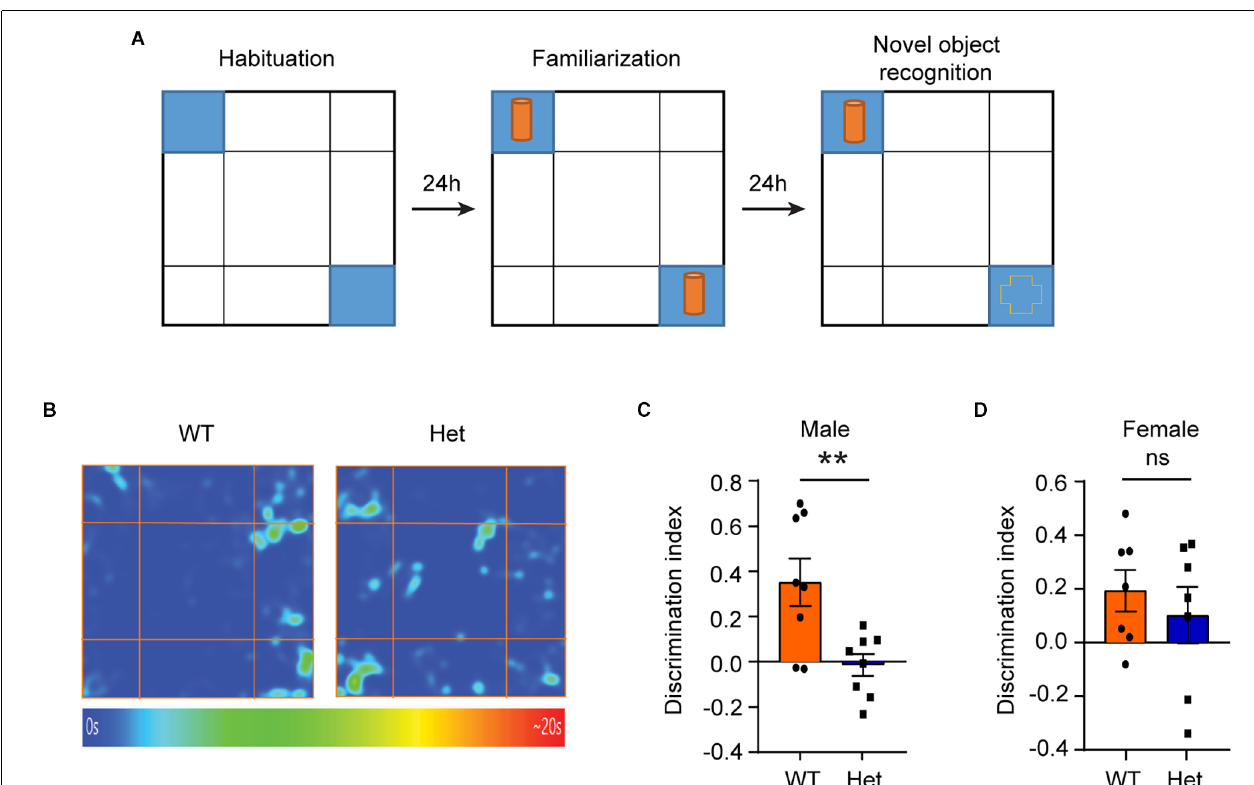
FIGURE 2 | Male heterozygous Kdm6b knockout mice display impaired object recognition memory. (A) Diagram showing the experimental procedure for the novel object recognition test. (B) Representative heatmap showing the time that male wild-type and heterozygote Kdm6b -KO mice spent exploring the familiar and novel object. (C) Quantitative results showing the NOR discrimination ratio of male mice. n = 8 per genotype. P-values calculated using a two-tailed t -test. ** P < 0.01. Error bars in graphs represent mean ± SEM. (D) Quantitative results showing the NOR discrimination ratio of female mice. n = 7 per genotype. P-values calculated using a two-tailed t -test. ns: not significant. Error bars in graphs represent mean ± SEM.